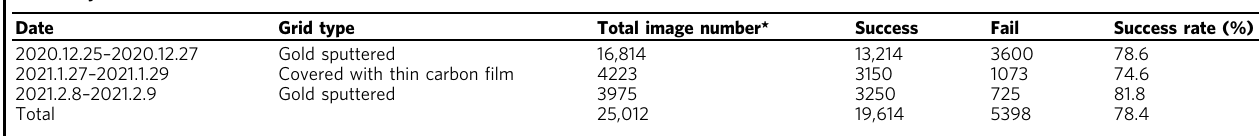
Table 2 Typical data statistics for locating carbon holes in SPA data collection with and without running yoneoLocr. Without